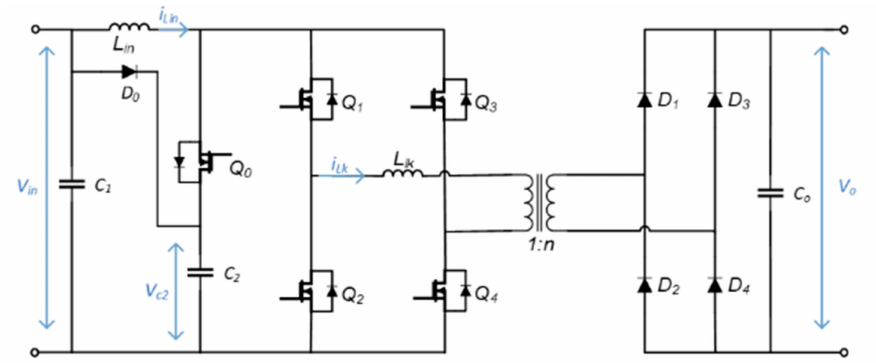
Figure 3. Topology of reconfigurable DC